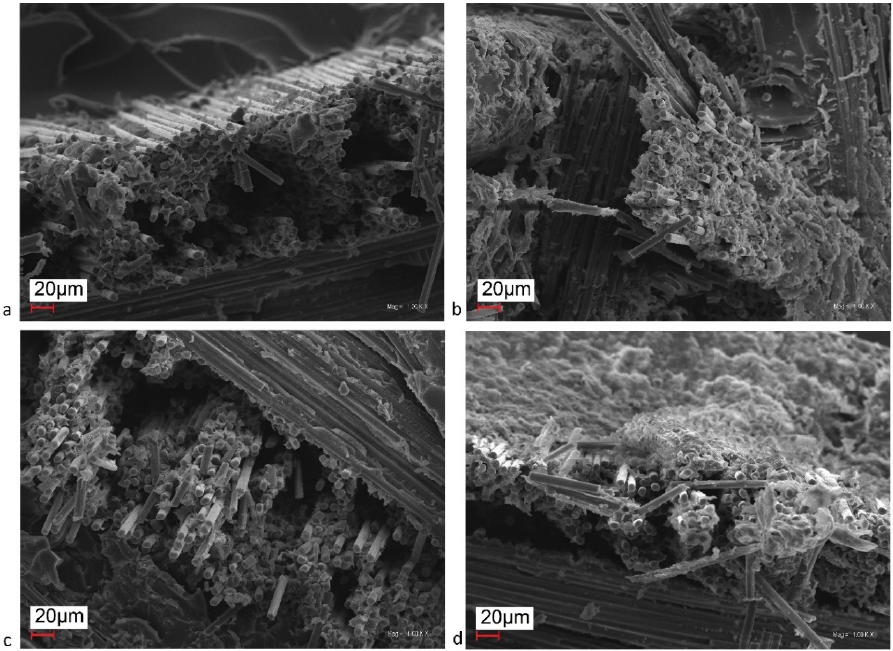
Figure 3. Structure of the composites ( a ) 0 BC, ( b ) 2.5 BC, ( c ) 5 BC, ( d ) 10 BC at a magnification of 1000×.